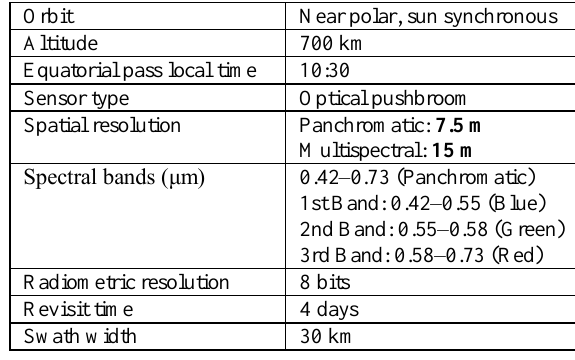
Table 1. Technical specifications of RASAT satellite sensor (Erdogan et al.,